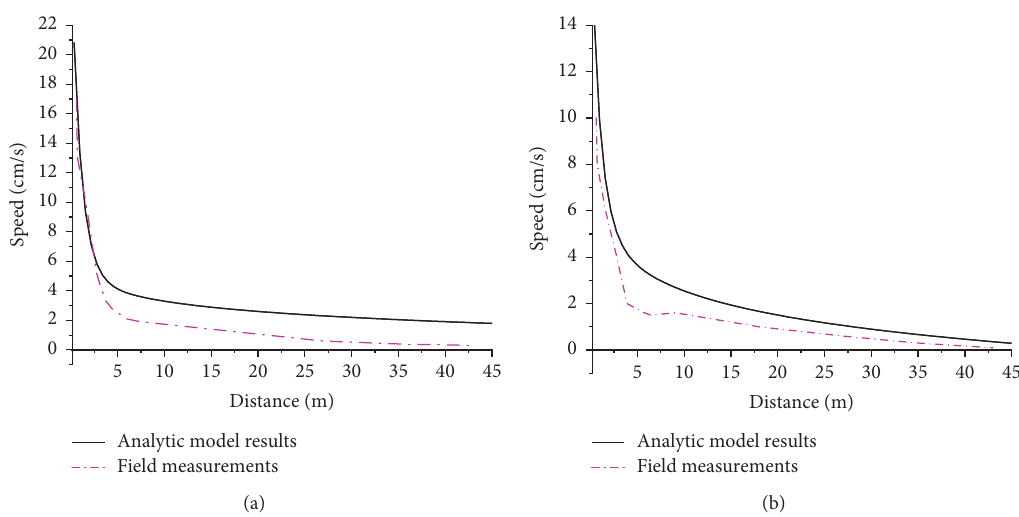
Figure 14: Comparison of analytical results and measured values of vibration velocity. (a) Variation of radial speed with axial distance. (b) Variation of axial speed with axial